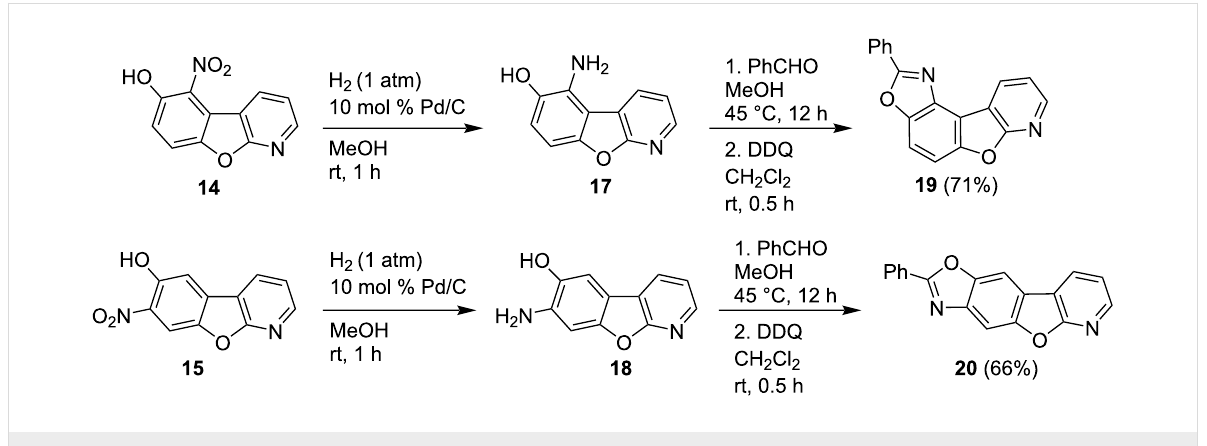
Scheme 3: Synthesis of isomeric oxazole-fused